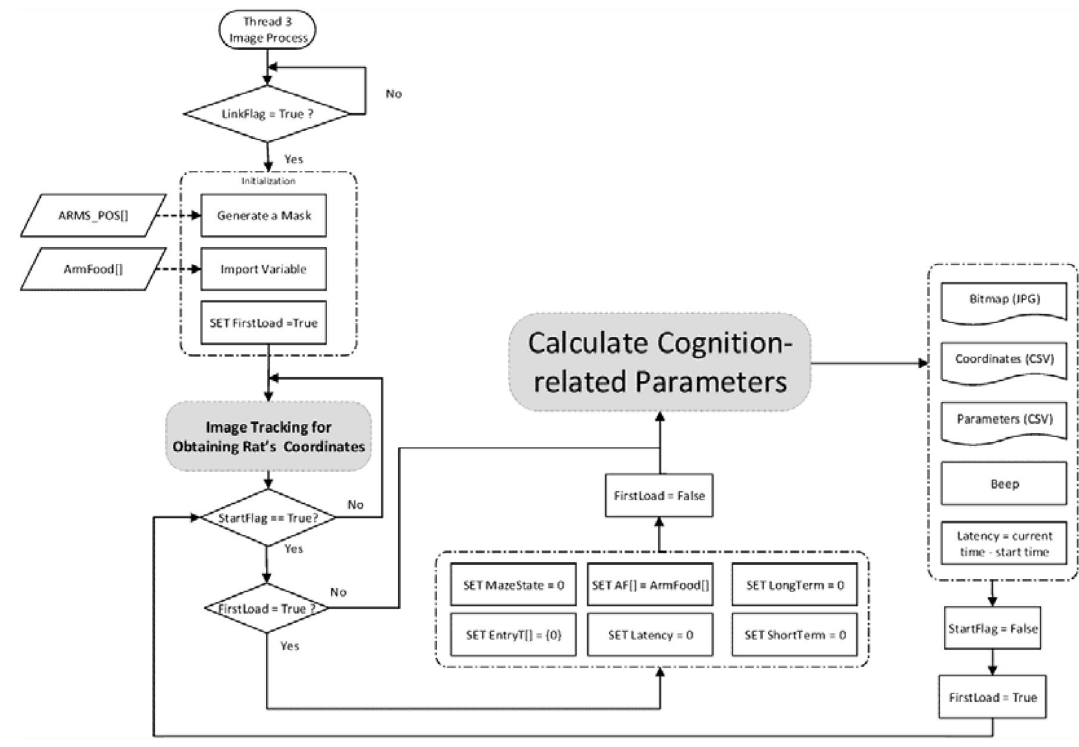
Figure 5. Flow of image processing